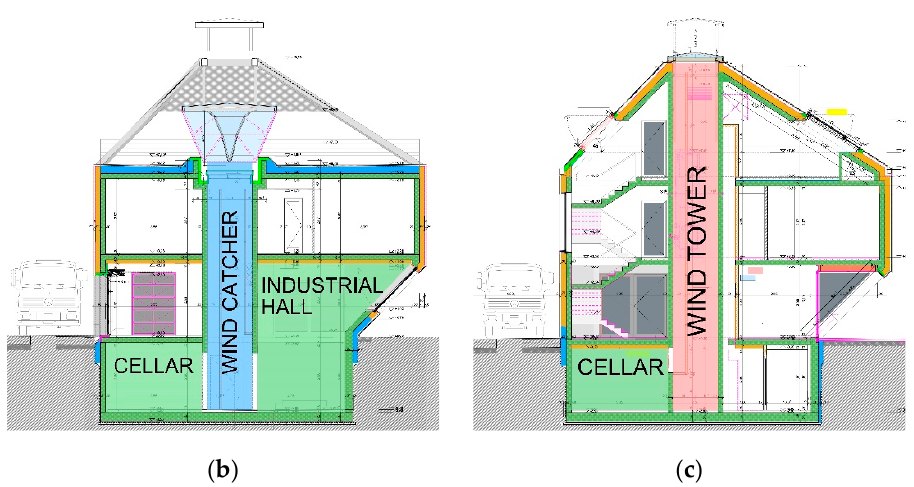
Figure 2. The Downdraught Passive Air Conduction System (DD PACS) with in- and outlets and chimney structures integrated in the architectural construction plan with airflow directions, velocities and volume flow rates (based on previous CFD study); ( a ) longitudinal section; ( b ) cross section through the wind catcher; ( c ) cross section through the exhaust wind tower. The reinforced concrete load-bearing structure is marked with green color.